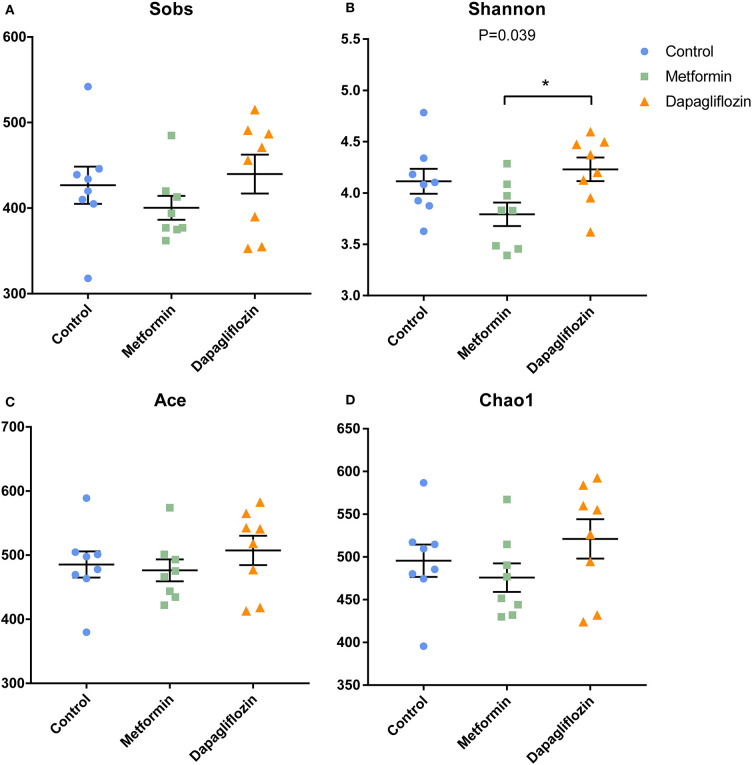
Indexes of alpha diversity in three groups. (A) Sobs (B) Shannon (C) Ace (D) Chao1. Data were expressed as mean ± SEM. *P < 0.05.